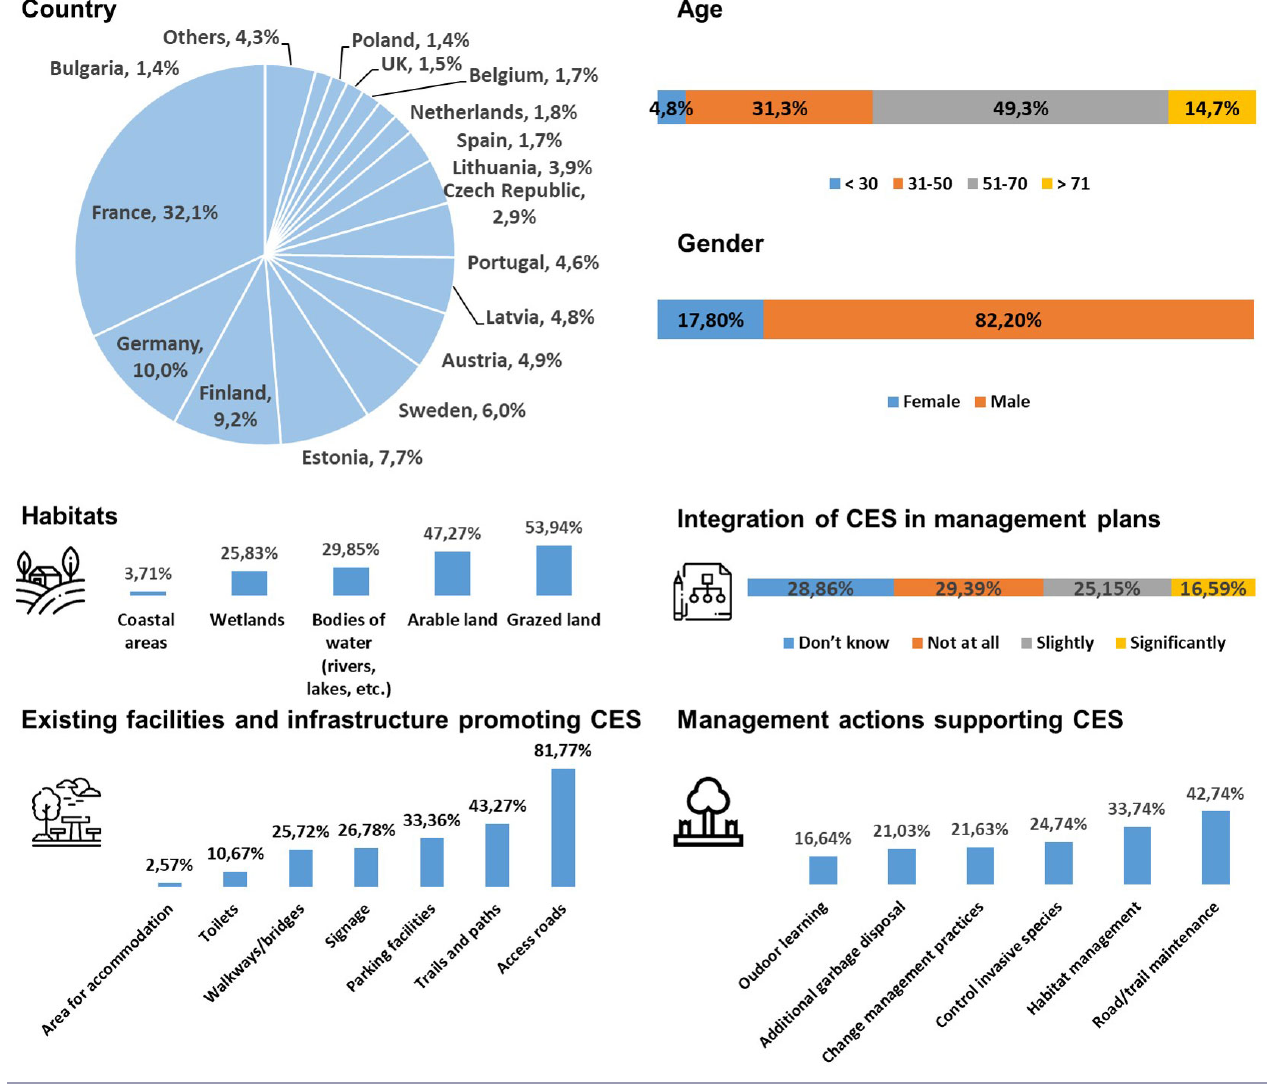
Fig. 1 . Descriptive statistics of the respondents, their land, and management practices. CES = cultural ecosystem